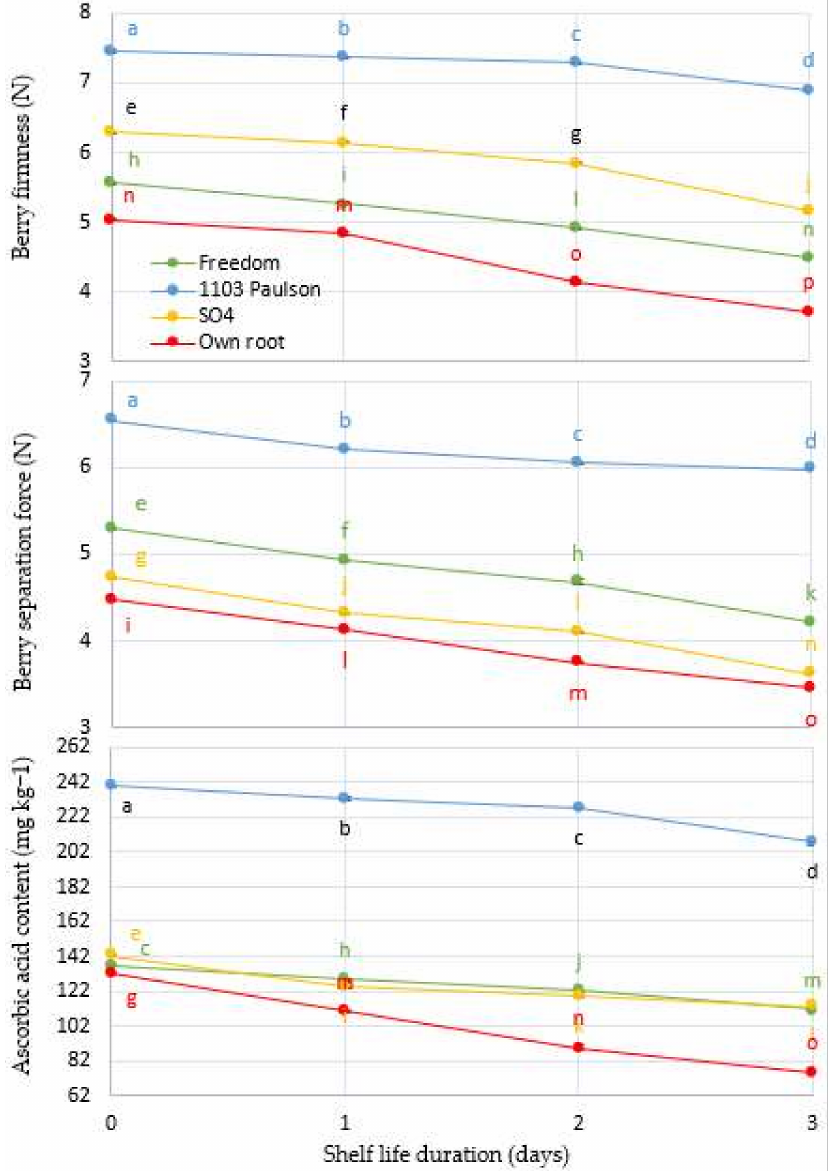
Figure 2. Interaction between Superior Seedless grapevine rootstocks (Freedom, 1103 Paulsen, SO4, and Own Root) and shelf life duration in days and effect on berry firmness, separation force, and ascorbic acid content during three days of shelf life (27 ± 1 ◦ C with 57 ± 3% RH). Significantly different samples, according to Tukey’s HSD test at 5%, are indicated by different